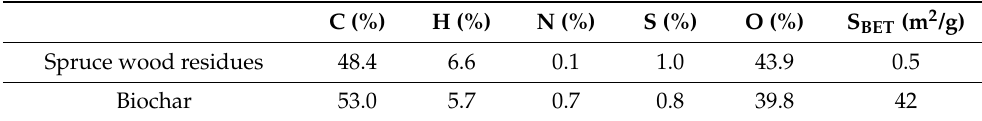
Table 2. Characterization of spruce wood residues and its respective biochar.